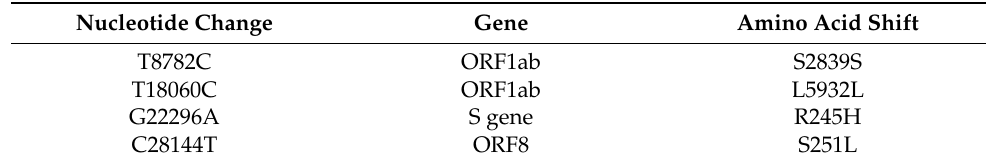
Table 2. Mutations observed from infected tracheobronchial lymph node when compared with viral inoculum. Genomes were mostly identical except at nucleotide positions 8782 and 18,060 of ORF 1ab; nucleotide position 22,296 of S gene and nucleotide position 28,144 of ORF8. Nucleotide Change Gene Amino Acid Shift T8782C ORF1ab S2839S T18060C ORF1ab L5932L G22296A S gene R245H ORF8